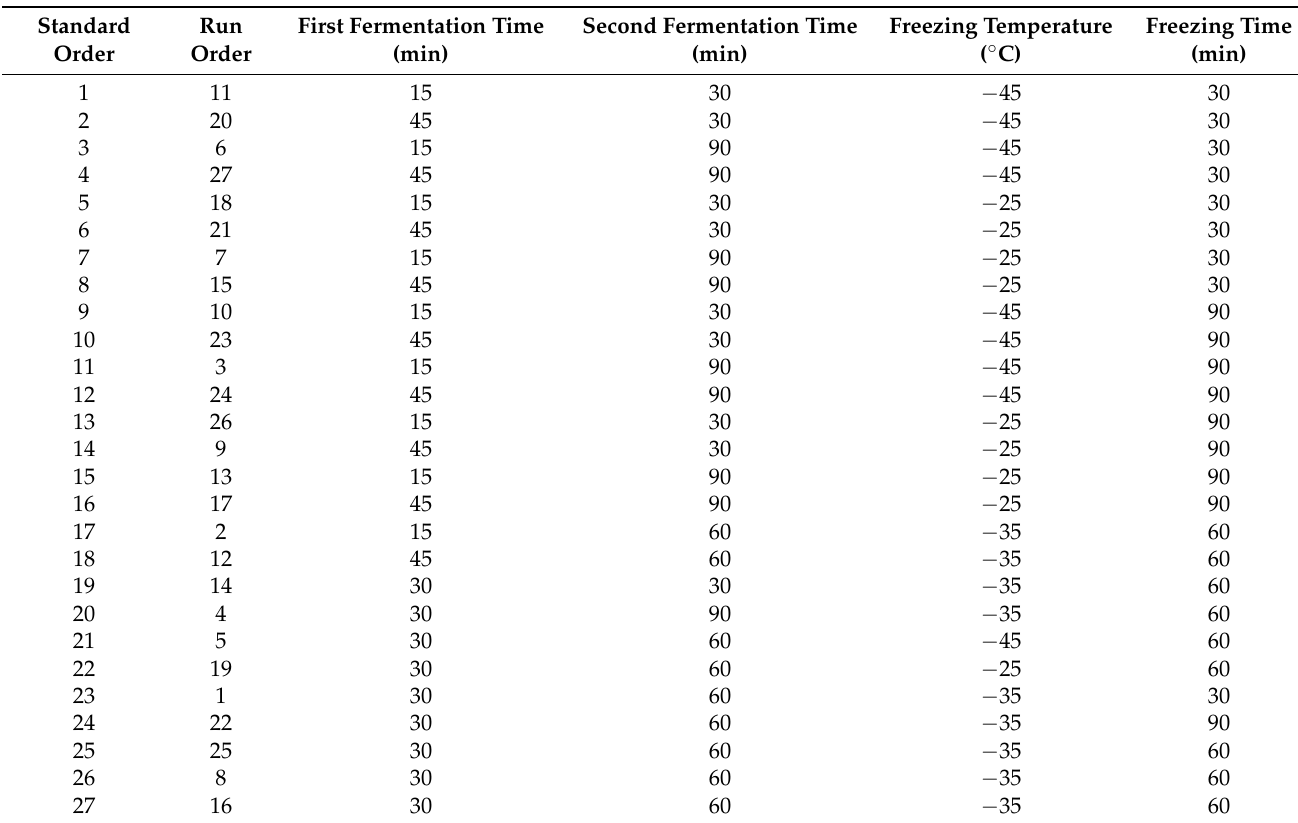
Table 1. Experimental design for processing conditions with four factors for preparing RTP and RTB frozen sweet bread